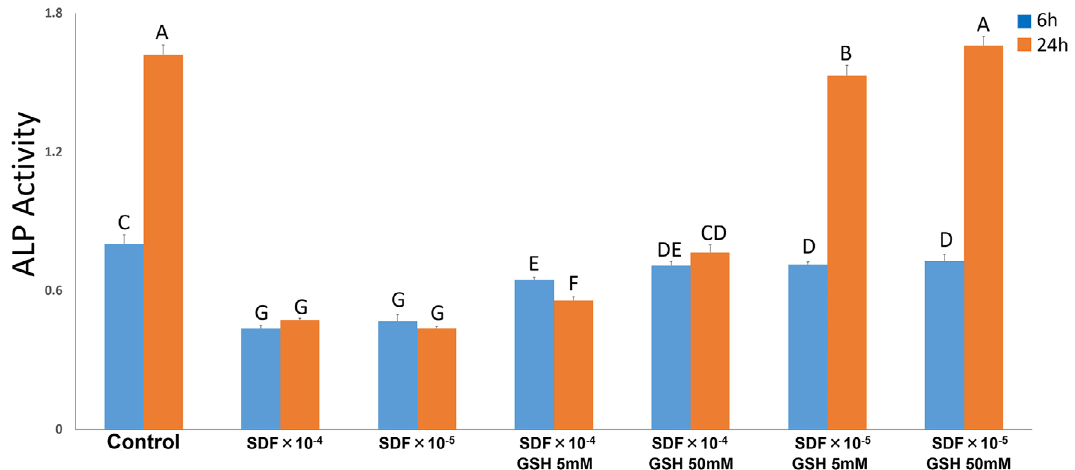
Figure 2- ALP activity of RPC-C2A cells cultured with diluted of SDF with and without GSH for 6 and 24 h. Data were analysed by using two-way ANOVA. letter indicates no significant differ-ence